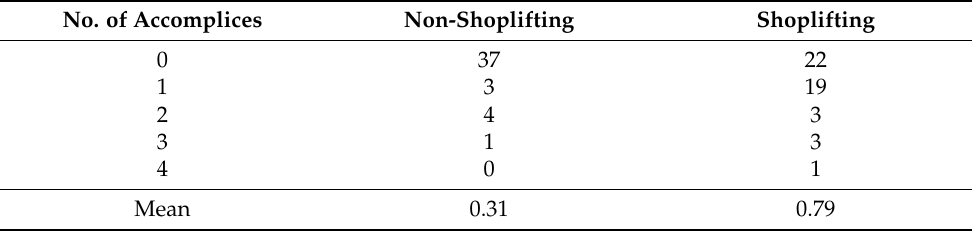
Table 5. Frequency of the number of accomplices.